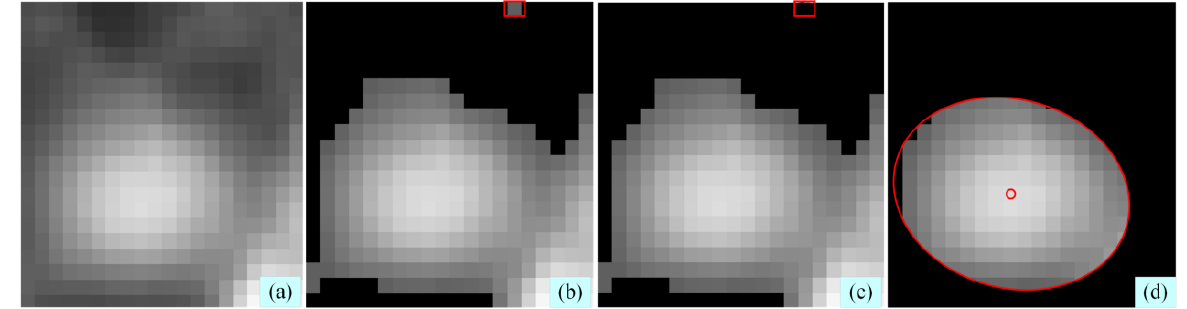
Figure 3. Threshold constraint algorithm for extracting the centroid of the ellipse fitting. ( a ) LFI. ( b ) The result of laser spot contour extraction based on threshold method. ( c ) Morphological processing to remove noise. ( d ) Determine the centroid coordinates of laser spot by ellipse fitting method and GCM.